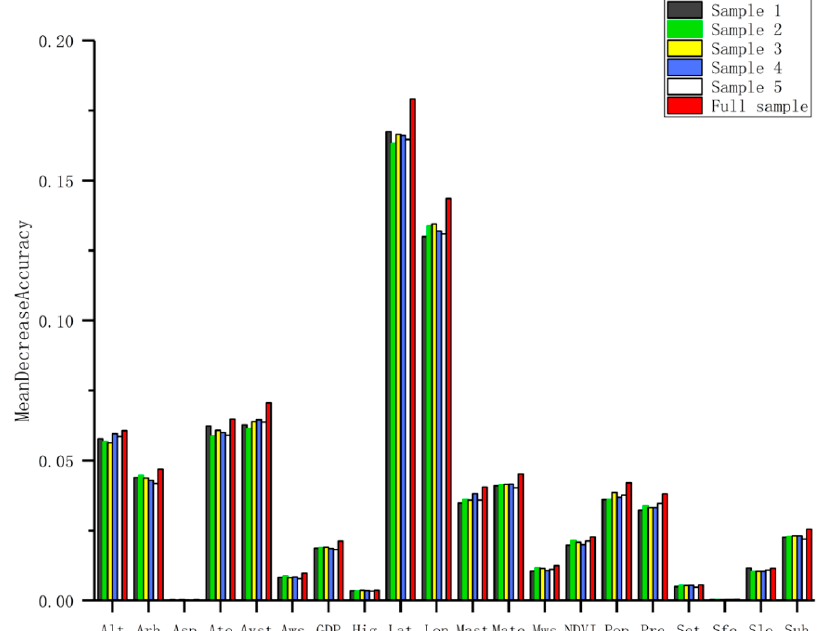
Figure 3. Feature subset importance.